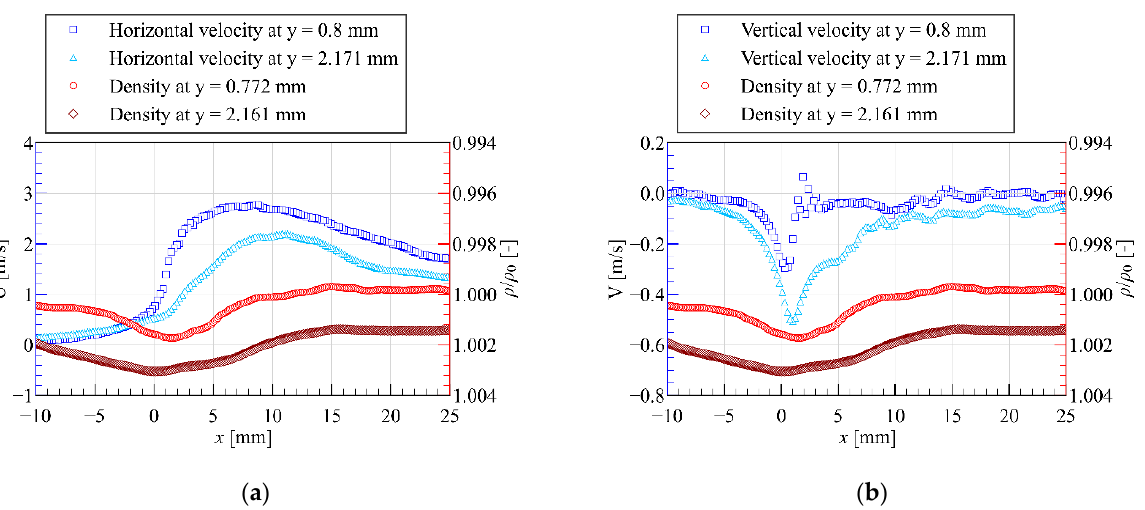
Figure 11. x -profiles of the flow and density field of the plate-PA: ( a ) x -profiles of the horizontal velocity ( y = 0.8 and 2.171 mm) and density ( y = 0.772 and 2.161 mm); ( b ) x -profiles of the vertical velocity ( y = 0.8 and 2.171 mm) and density ( y = 0.772 and 2.161 mm).